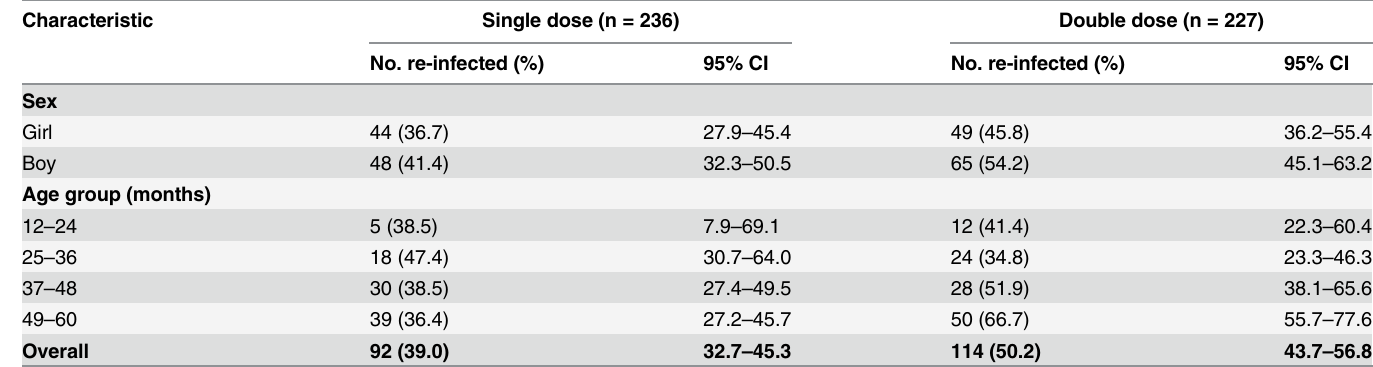
Table 6. Comparison of S . mansoni prevalence of re-infection between single and double dose treatments, stratified by sex and age group,8 months post-treatment. Characteristic